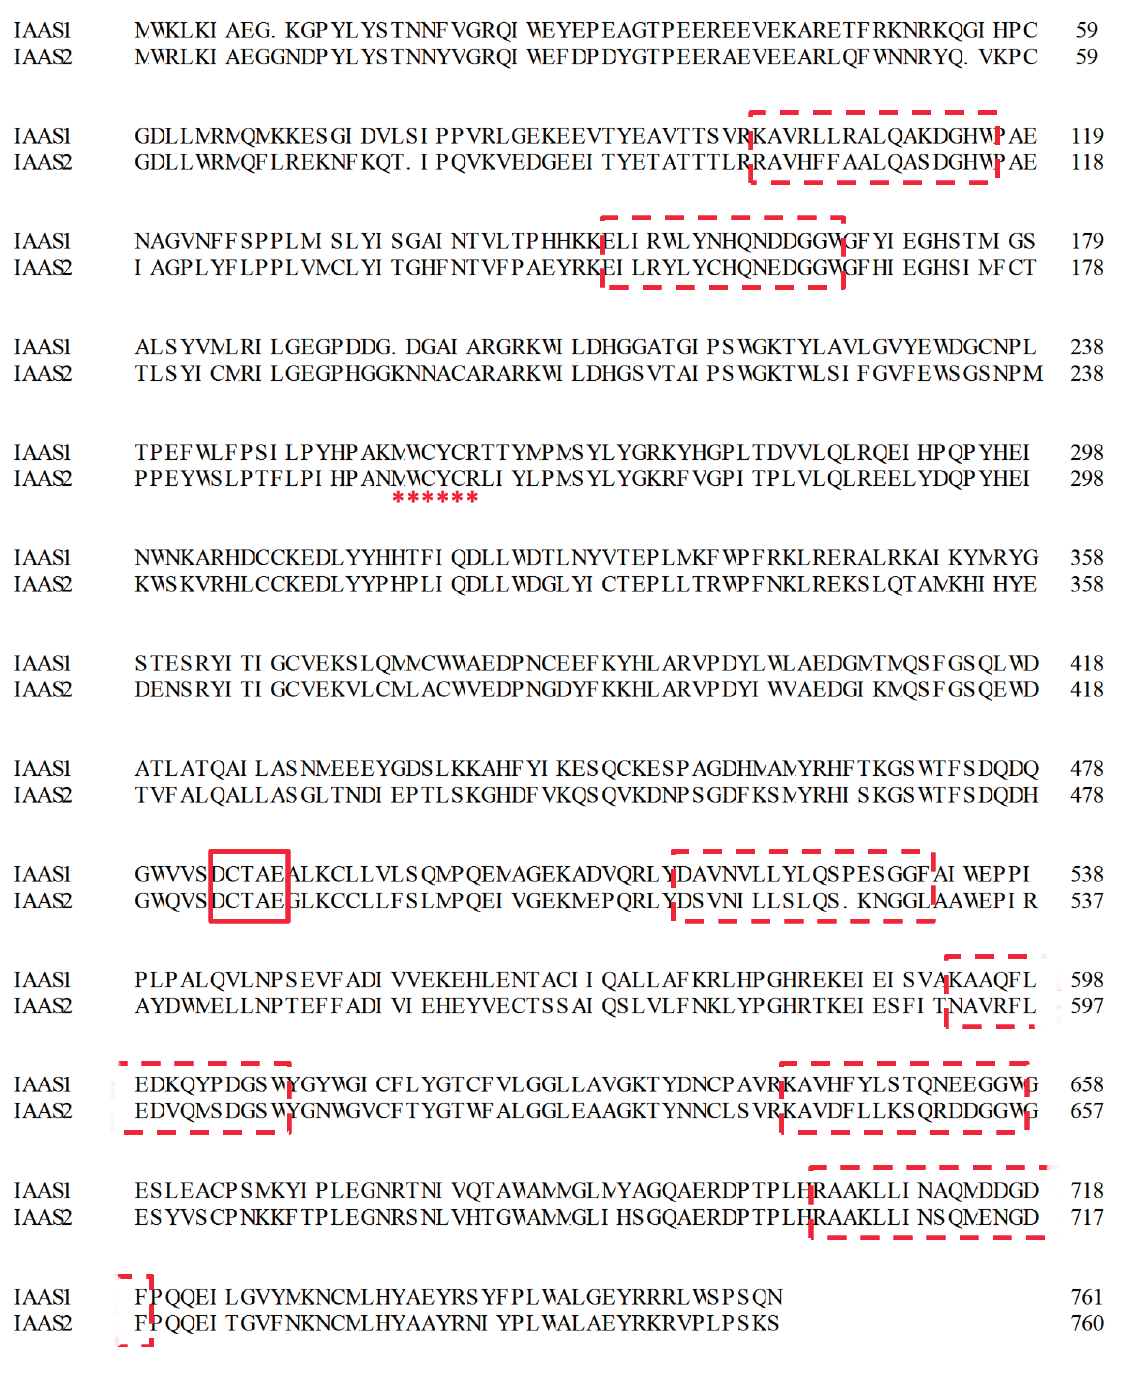
Figure 2. Amino acid sequences of IaAS1 and IaAS2 . The conserved QW motifs are highlighted by dashed line boxes, the DCTAE motif is emphasised by a solid line box and the MWCYCR motif is marked by